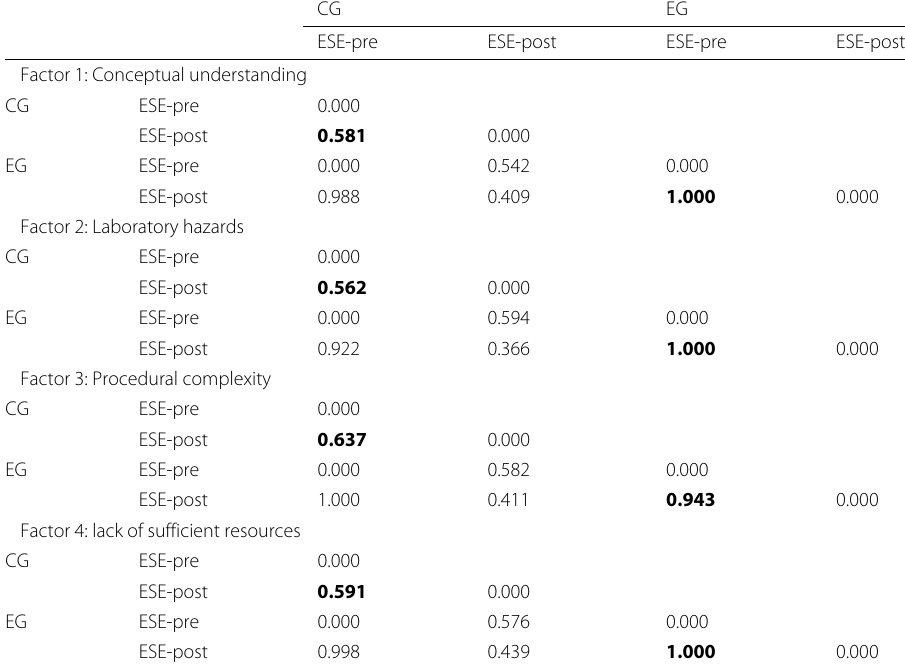
Boldface numbers represents pre- and post results of respective